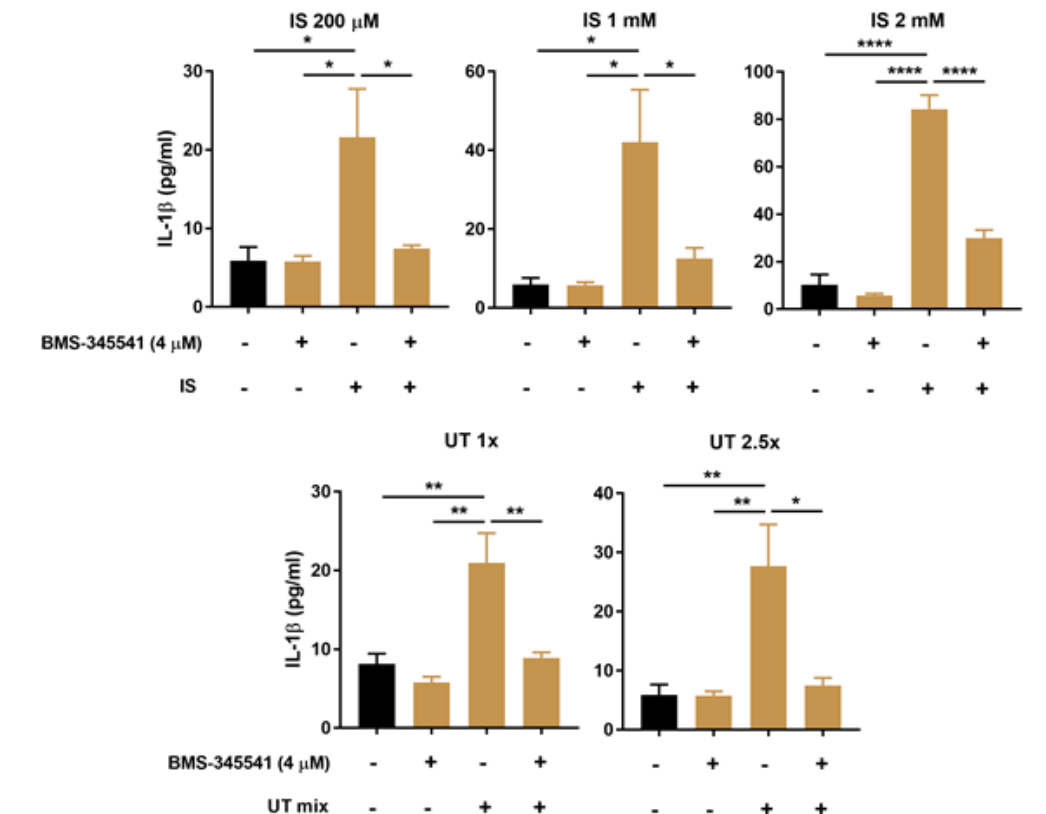
Figure 5. Effect of PBUTs on NF- κ B signaling and the role of NF- κ B on PBUTs-mediated caspase-1 activity and IL-1 β production in ciPTEC-OAT1. ( A ) Representative images (20 × ) and ( B ) quantification of p65 nuclear expression in ciPTEC- OAT1 after 1 h incubation with IS (200 µ M, 1 mM, 2 mM), UT mix (1 × , 2.5 × ), LPS (200 µ g/mL) or TNF- α (100 ng/mL). ( C ) Relative mRNA expression of IL-1 β upon 4 h exposure to either IS (200 µ M, 1 mM, 2 mM) or UT mix (1 × , 2.5 × ), in the absence or presence of specific IKK inhibitor BMS-345541 (4 µ M) and compared to control (untreated ciPTEC-OAT1). ( D ) IL-1 β secreted levels (pg/mL) by ciPEC-OAT1 following 24 h treatment with IS (200 µ M, 1 mM, 2 mM) and UT mix (1 × , 2.5 × ), in the absence or presence of BMS-345541 (4 µ M). Data are derived from at least two independent experiments performed at least in duplicate and expressed as mean ± SEM. * p < 0.05, ** p < 0.01, *** p < 0.001, **** p < 0.0001 (One-way ANOVA followed by Dunnett’s multiple comparison test, using either untreated or PBUTs treated cells as a